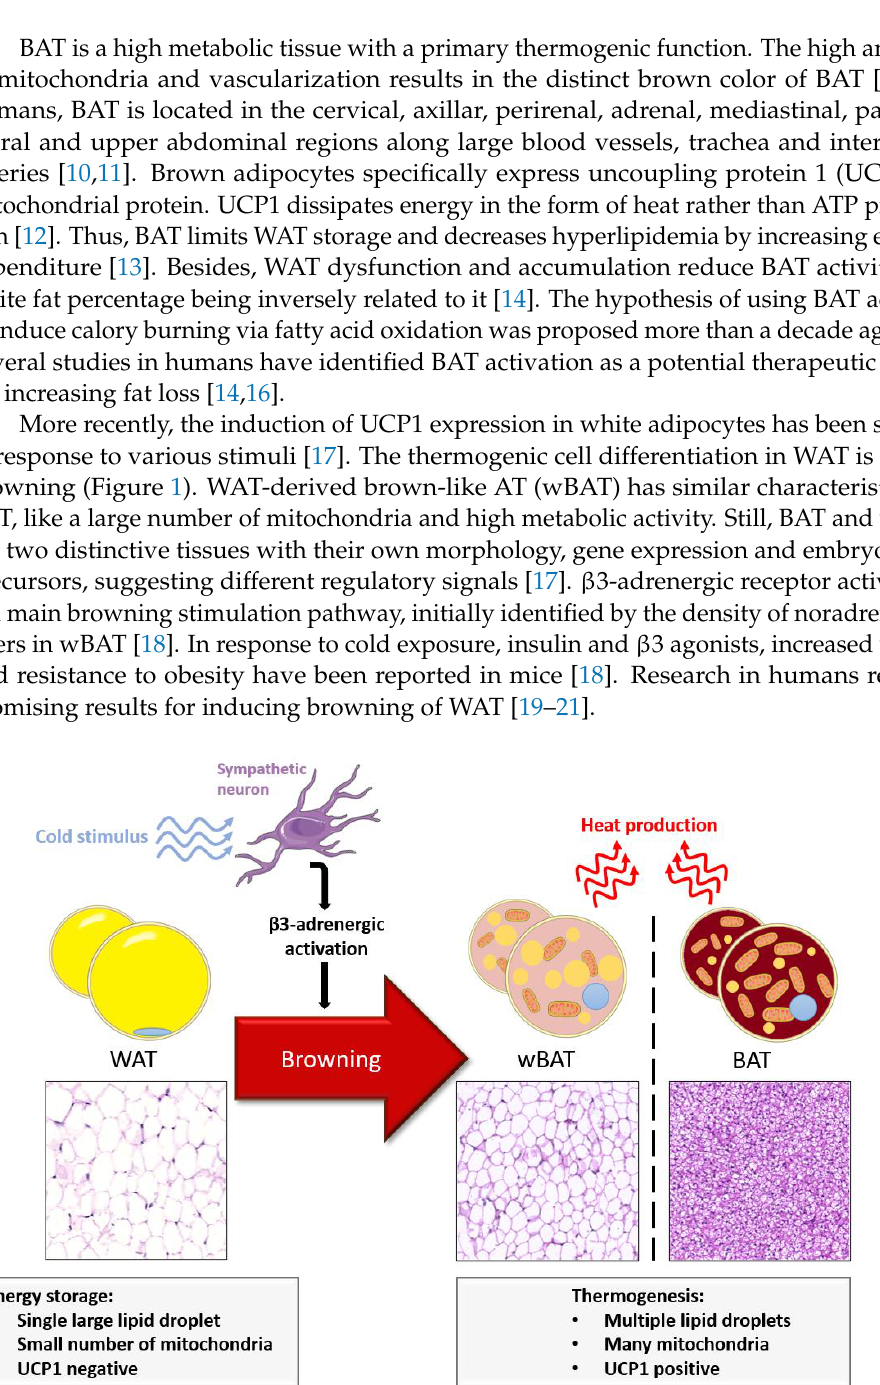
Figure 1. Cold exposure physiologically induces the browning process by sympathetic fiber innervation via a β3-adrenergic stimulation of white adipose tissue (WAT). The beige phenotype, enriched with mitochondria, allows for non-shivering thermogenesis like brown adipocytes due to the expression of UCP1. Photographs represent hematoxylin and eosin (HE) staining of WAT, WAT-derived brown-like adipose tissue (wBAT) and brown adipose tissue (BAT) in mice. In the present review, the potential benefits of BAT activation and WAT-to-BAT trans- differentiation will be discussed in the context of atherosclerosis, focusing on the therapeu- tic